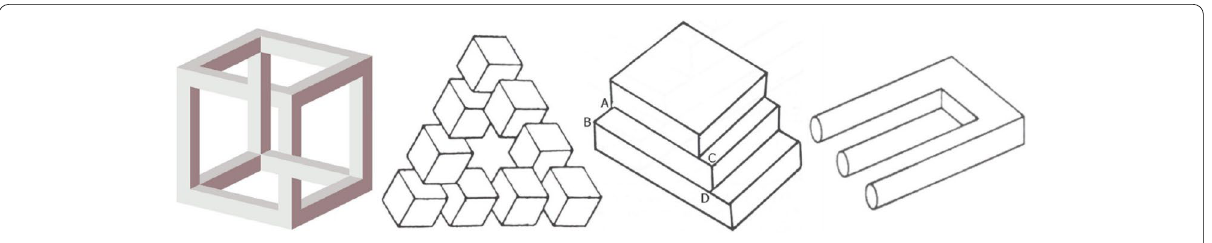
Fig. 30 Different types of impossible objects in ref. [74]